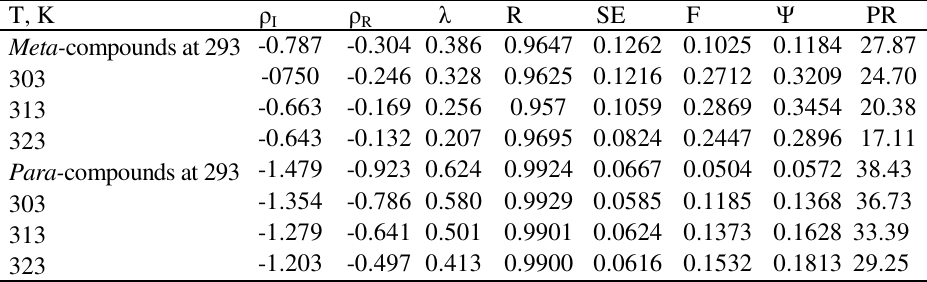
Table 4. Temperature dependence of the reaction constants for the oxidation of meta- and para- substituted benzyl alcohols by